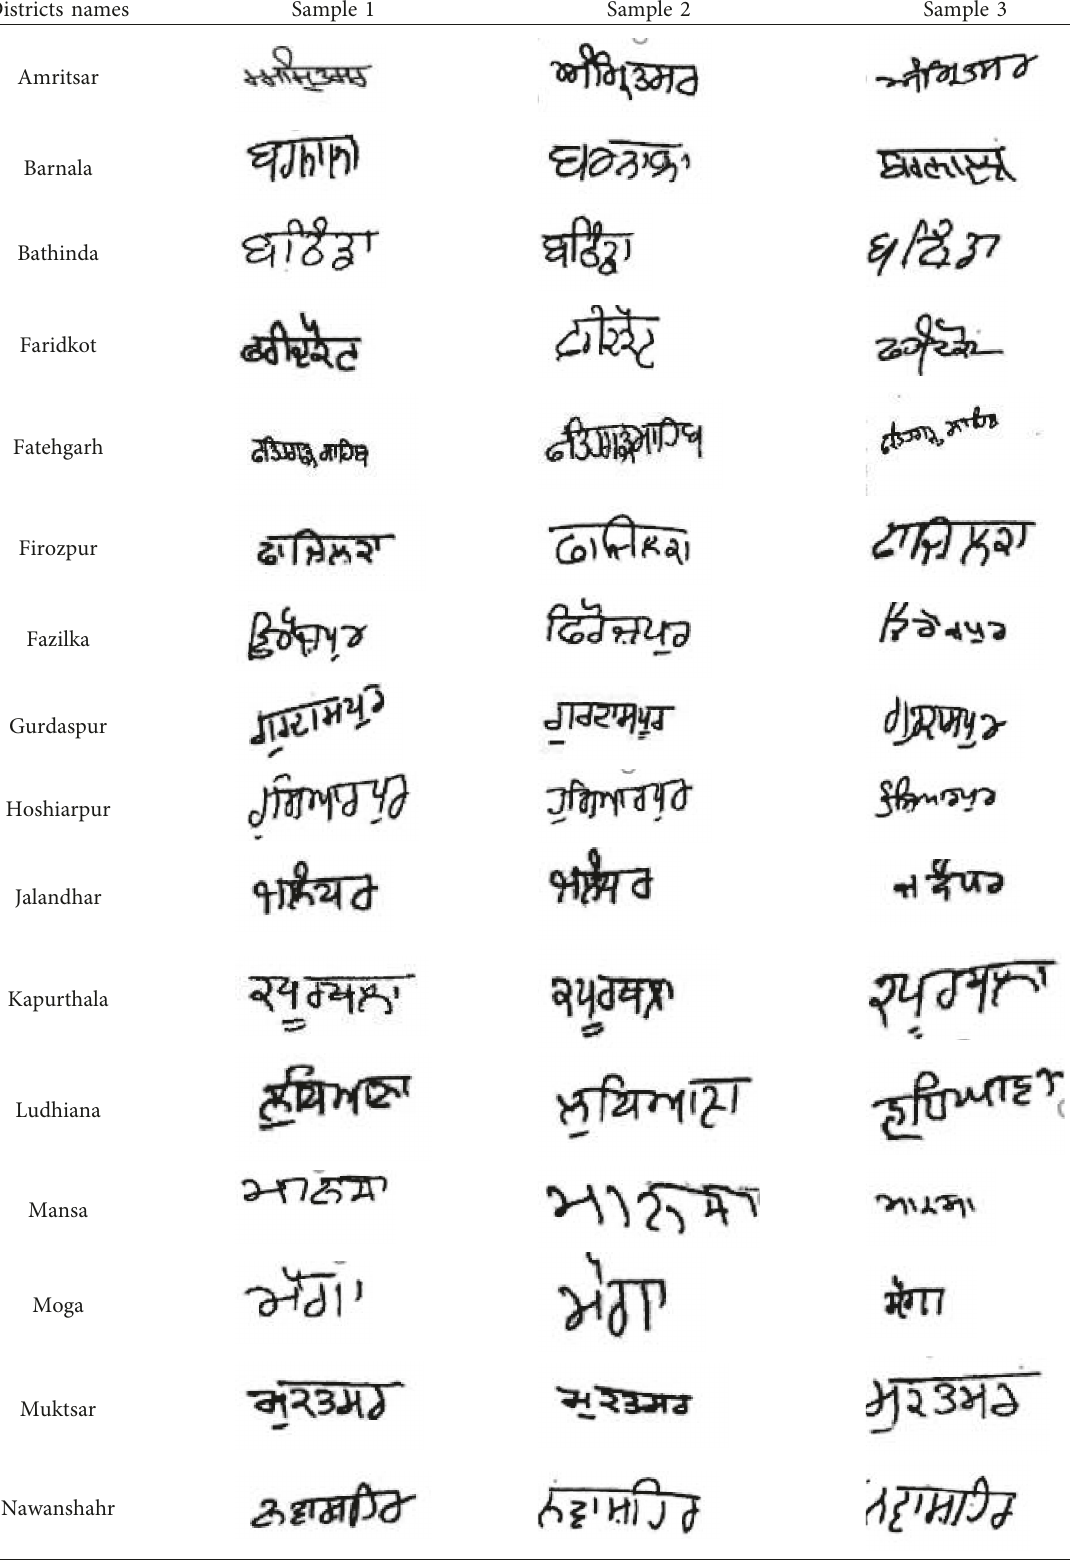
Table 1: Districts names written with their corresponding prepared